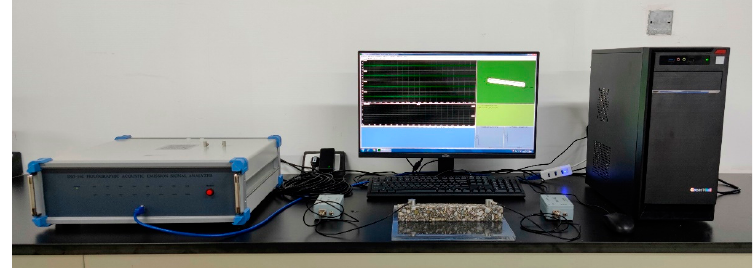
Figure 3. AE signal acquisition and analysis system.